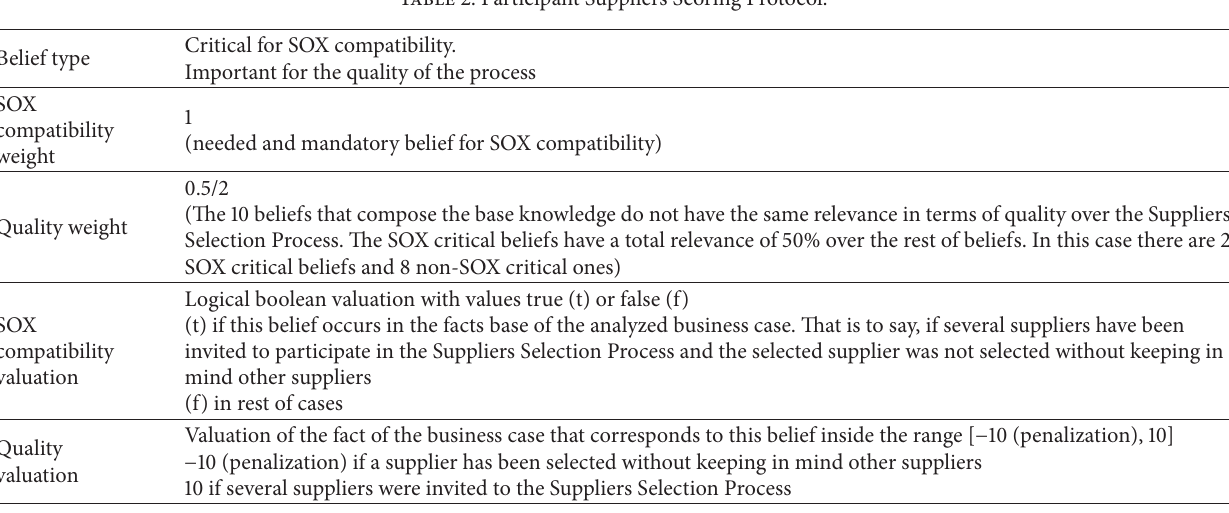
Table 2: Participant Suppliers Scoring